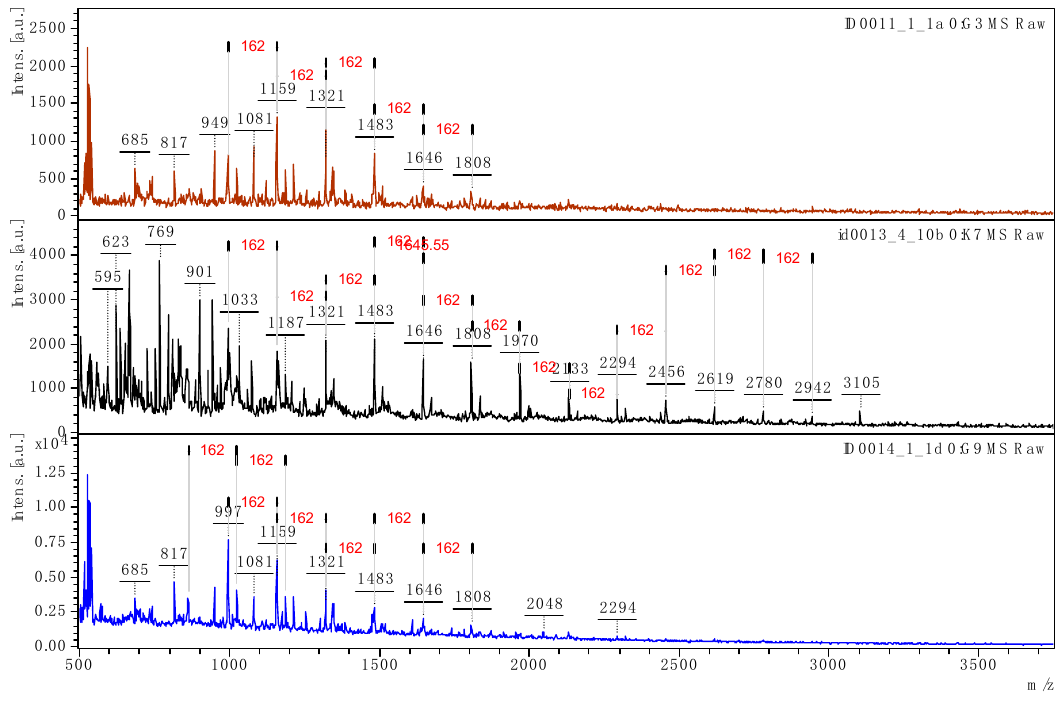
Figure 4. MALDI TOF mass spectrum of L9, L10, and L11 in the mass range 500–3700 Da.